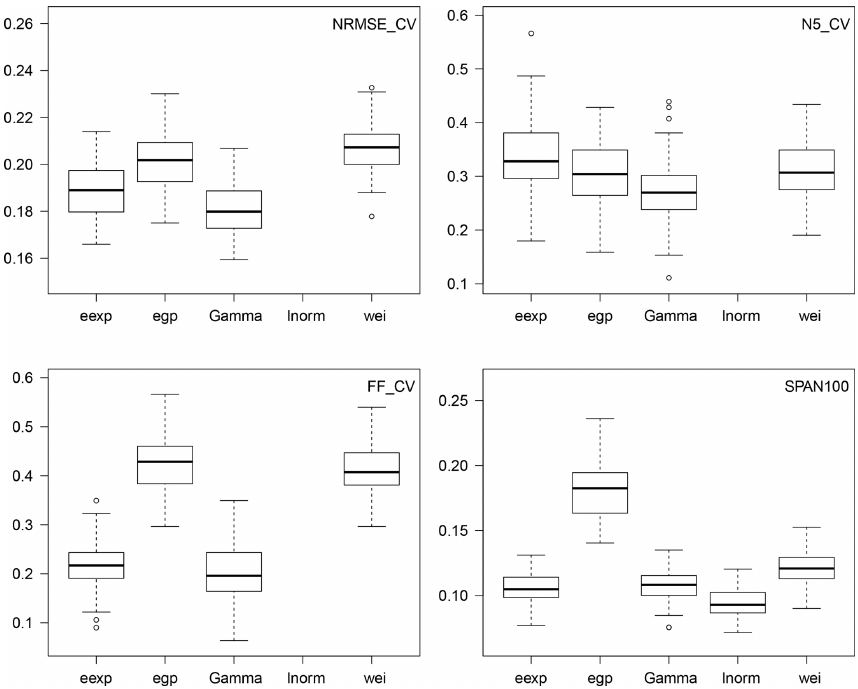
Figure 8. Scores of cross-validation when G s,k is either the extended exponential (eexp), extended generalized Pareto (egp), Gamma (gamma), lognormal (lnorm) or Weibull (wei) distribution, with S = 2 and K = 3. Each boxplot contains 100 points. The boxplots of reliability scores in the lognormal case are missing because they lie far above the upper range of depicted